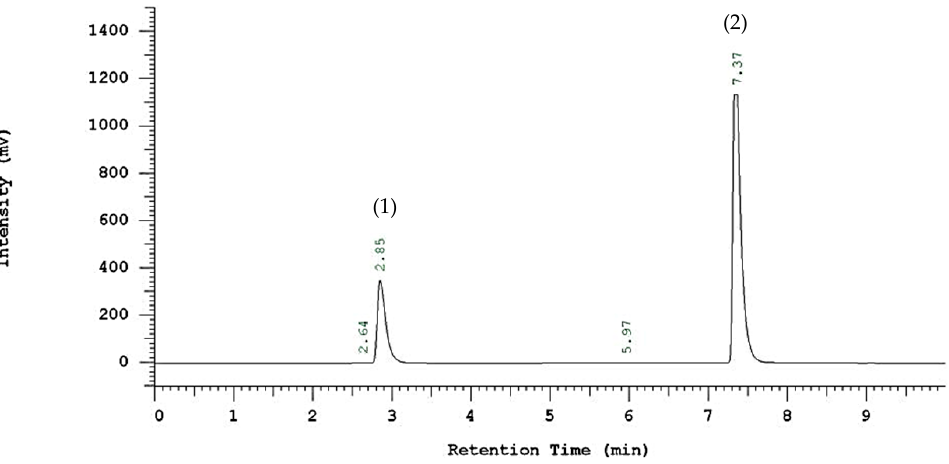
Figure 7. HPLC chromatogram of ferulic acid and its ester form. (1) ferulic acid; (2) 2-ethylhexyl ferulate.